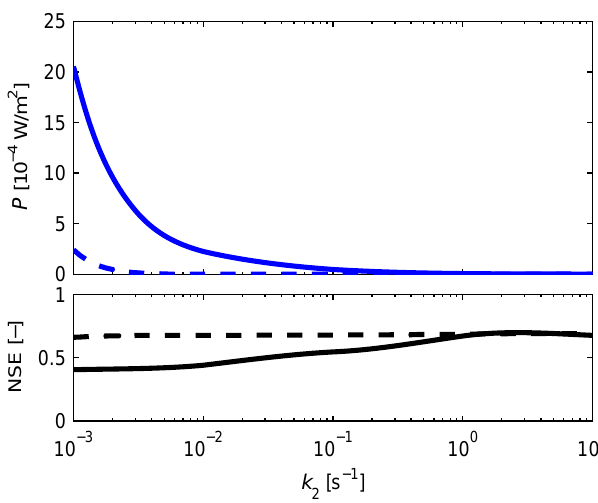
Fig. 5. Sensitivity of k 2 to power by flux Q 2 that leaves the slow runoff reservoir and the corresponding Nash–Sutcliffe model effi- ciency (NSE) for the HJ Andrews watershed 2. The input flux ( G ) for the solid line was derived from the point of maximum power in G of the solid line in Fig. 2a, while the input flux for the dashed line was derived from the point of maximum power in Q d of the dashed line in Fig. 2a (see Table 1 for the used parameters). The fast runoff reservoir was also parameterized to be able to determine the NSE of the total